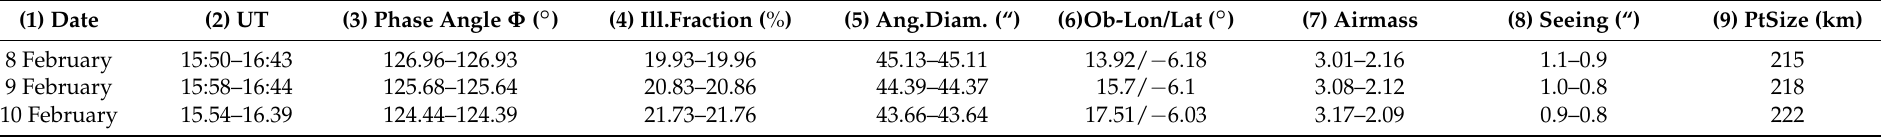
Table 1. Orbital geometry and circumstances of ground-based observations: (1–2) Date/UT interval; (3–5) disk appearance; (6) sub-observer longitude and latitude (planetodetic); (7–9) observing conditions and geometry.